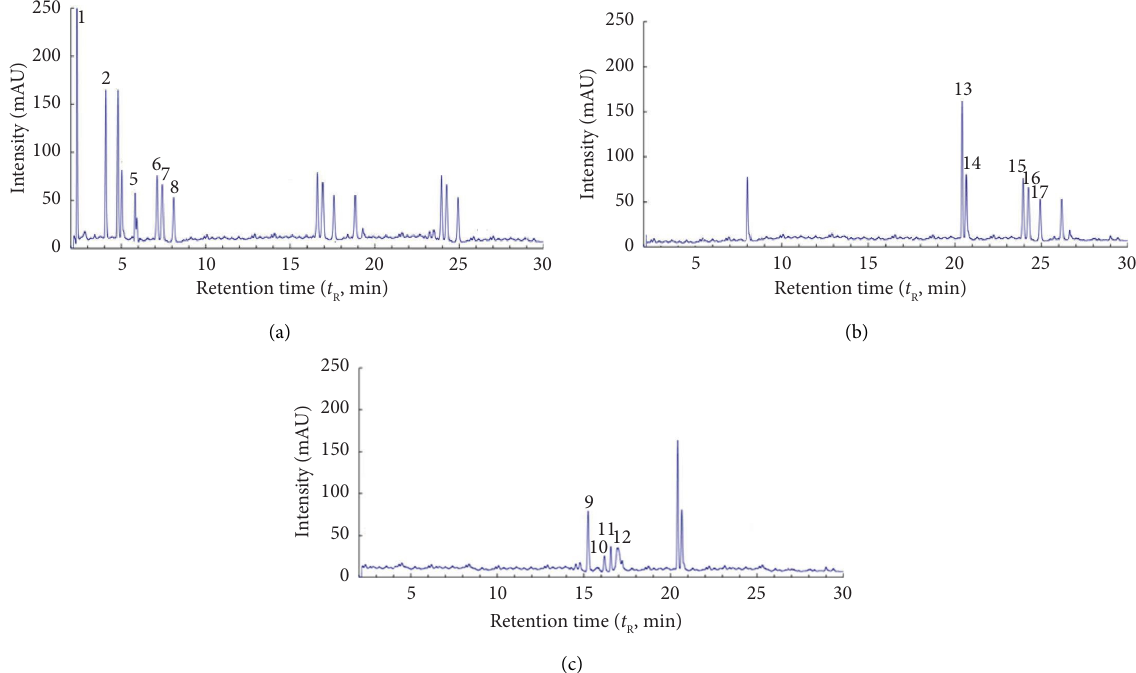
Figure 3: HPLC profles at 325nm (a), 354nm (b), and 560 nm (c) of the grape pomace extract obtained using the betaine-based eutectic solvent Table 3: Characterization of the main compounds of the grape pomace extract using their spectral characteristics in HPLC-DAD (Rt, λ max, and MS2).